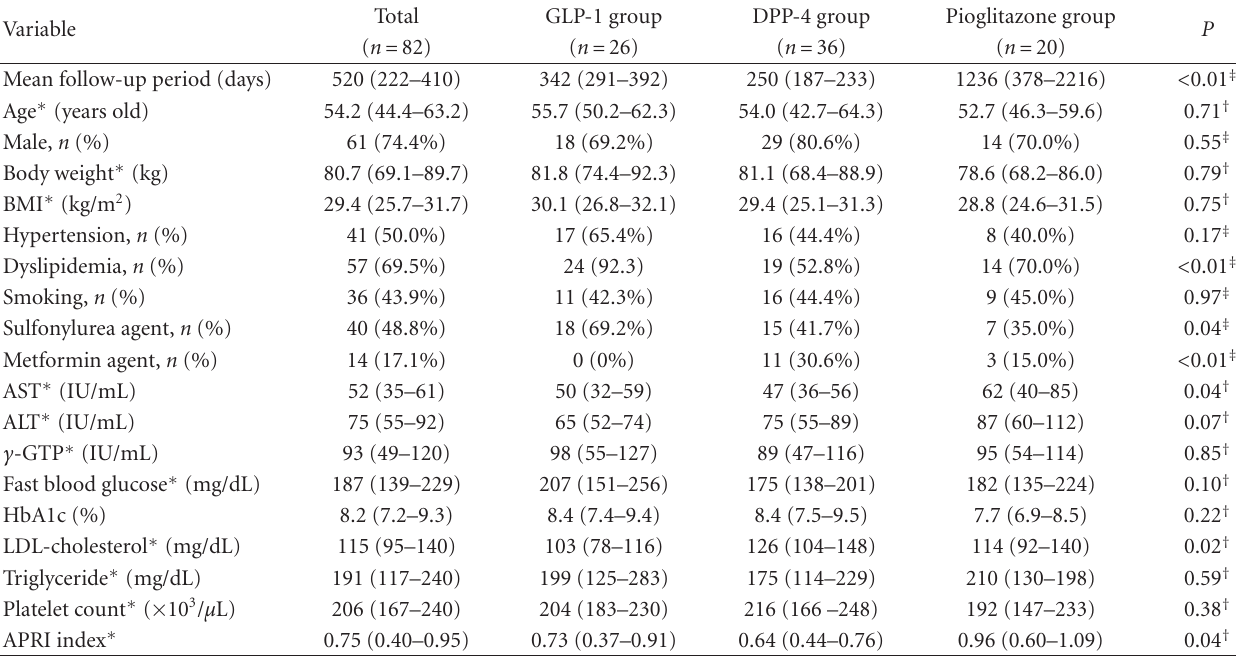
Table 1: Baseline characteristics of